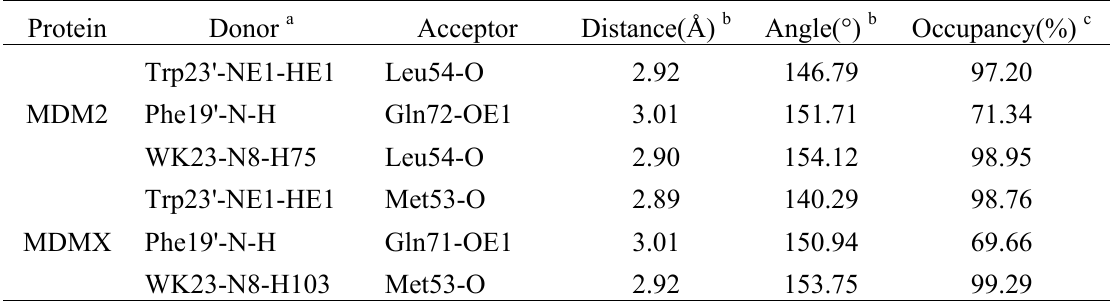
Table 2. Hydrogen bonds formed between the inhibitors and